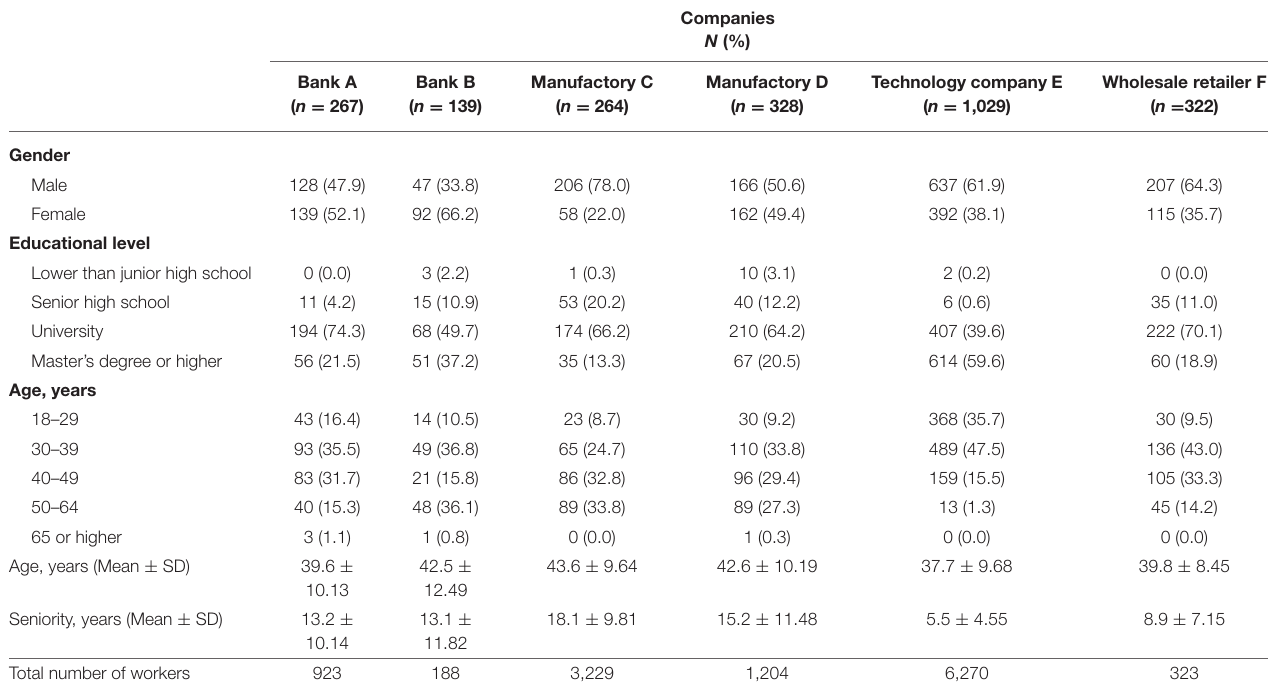
TABLE 2 | Demographic characteristics of